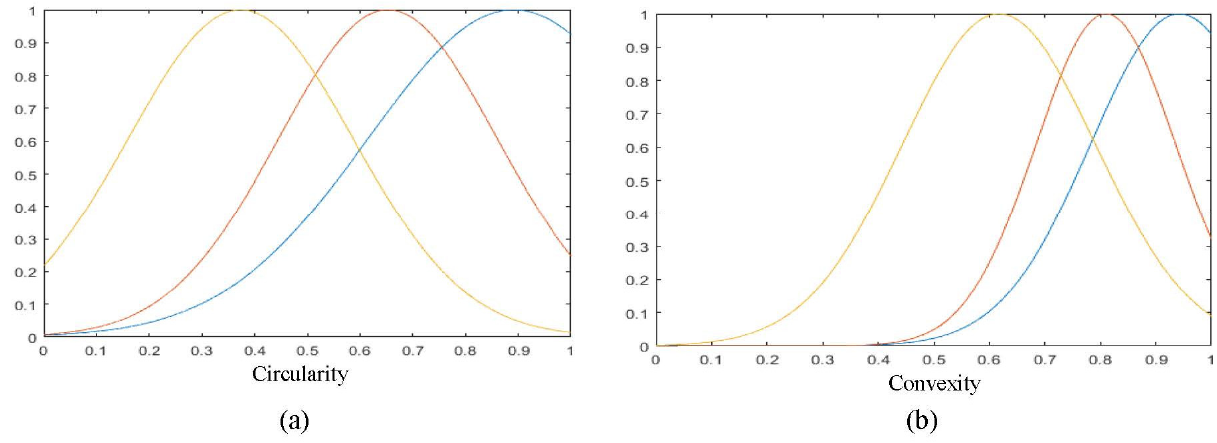
Figure 9. Membership functions used in the fuzzification step for the Circularity ( a ) and Convexity ( b ) inputs (blue: immature, red: inhibited, and yellow: mature). Table 5. Correct classification rate of the three classes with the FIS1 system.